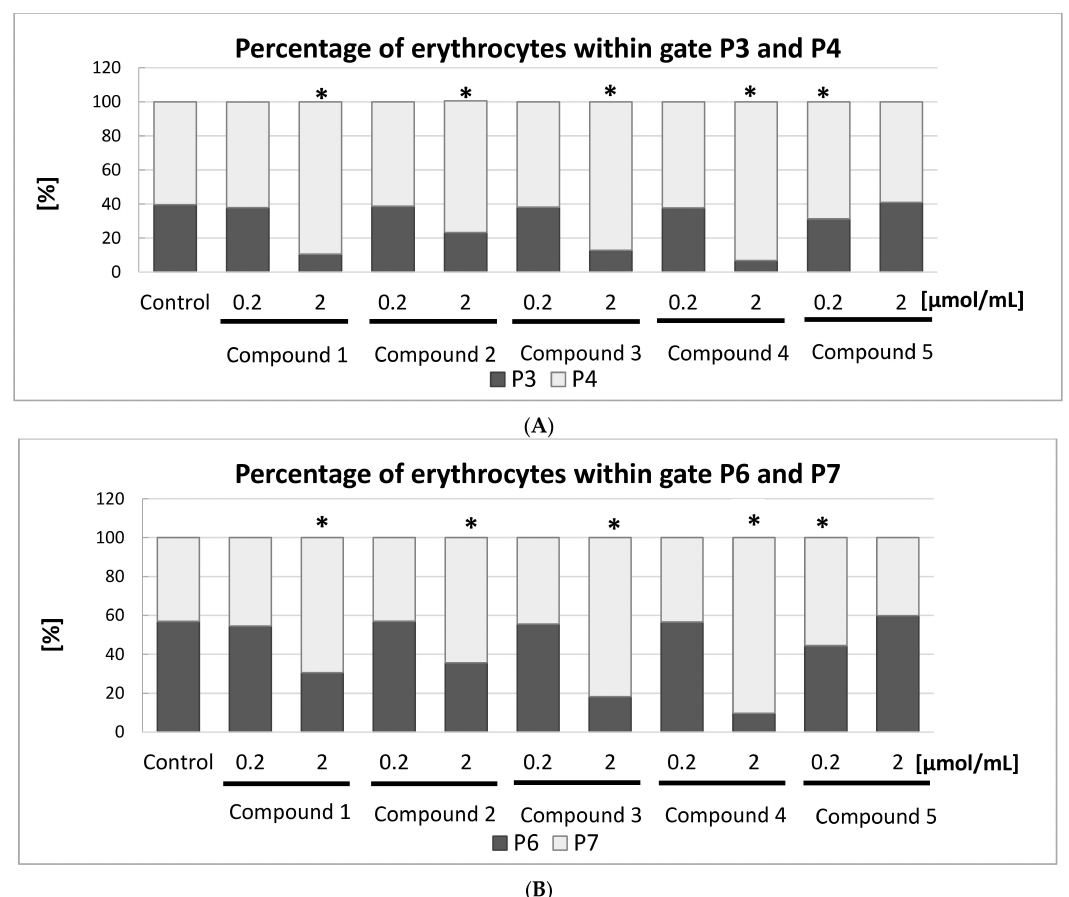
Figure 10. Effects of iminodiacetic acid derivatives on erythrocytes. ( A ) Percentage of all RBCs (mean ± SD, n = 3) divided into P3 and P4 gates. The highest tested concentrations (2.0 µ mol/mL) of compounds 1 – 4 and compound 5 at concentration of 0.2 µ mol/mL contributed to significant changes in the amount of RBCs within these gates; ( B ) Percentage of all RBCs divided into P6 and P7 gates. The highest tested concentrations (2.0 µ mol/mL) of compounds 1 – 4 contributed to significant changes in the amount of RBCs within these gates. * p < 0.05 vs.